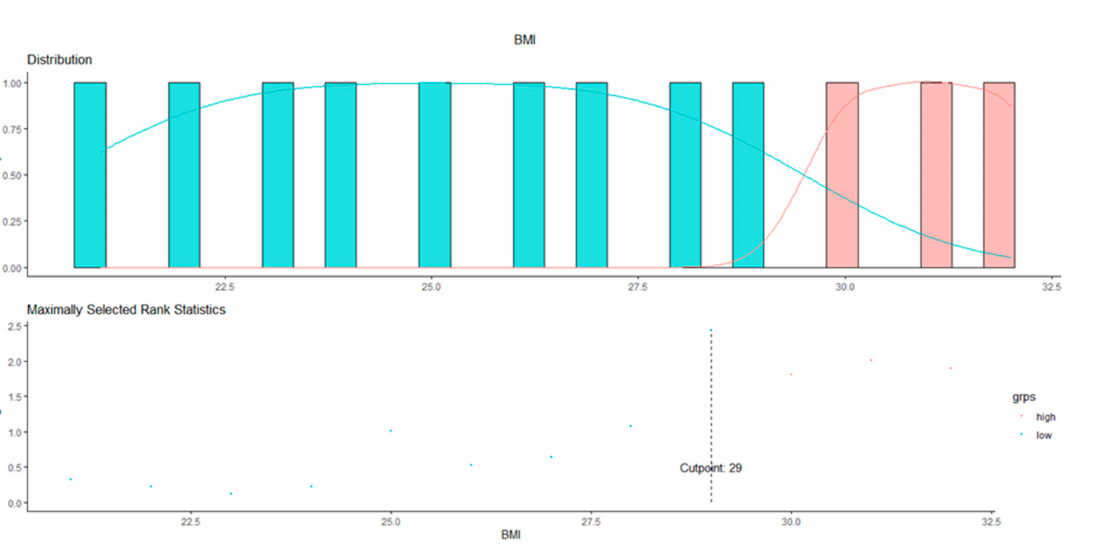
Figure 2. BMI cut-off identification in AI-treated BC patients.